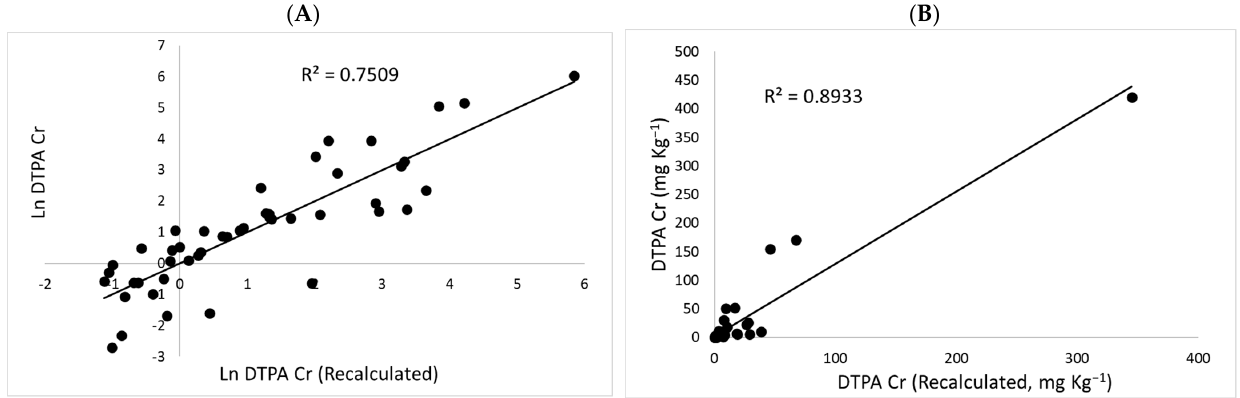
Figure 3. Goodness of fit for measured and recalculated fractions of DTPA Cr in ( A ) logarithmic scale and in ( B ) mg Cr Kg –1 of soil.